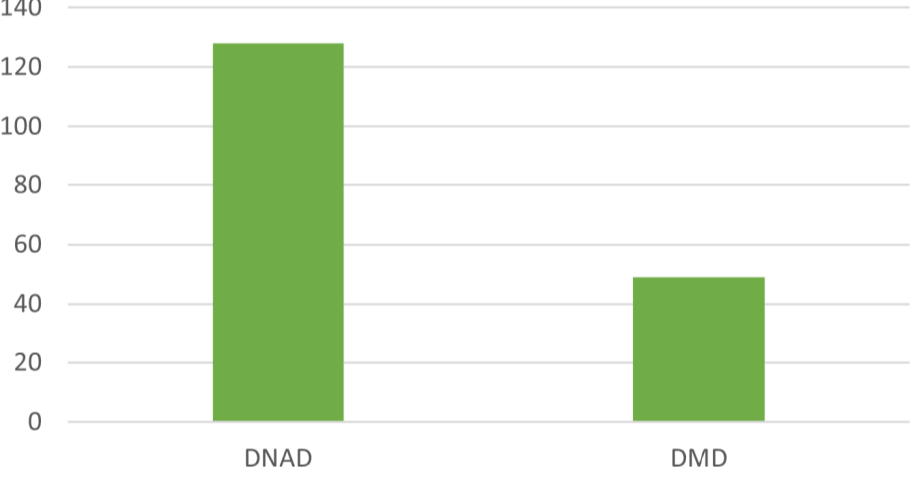
Figure 5. Comparison of numerous studies published in veterinary medicine journals.